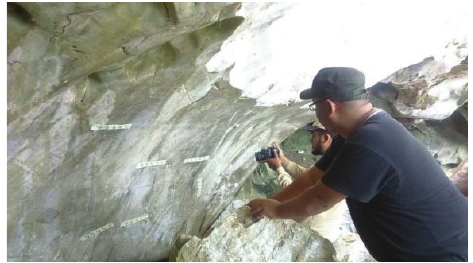
Figure 5: Data acquisition of the ancient paintings using Sony F828 digital camera